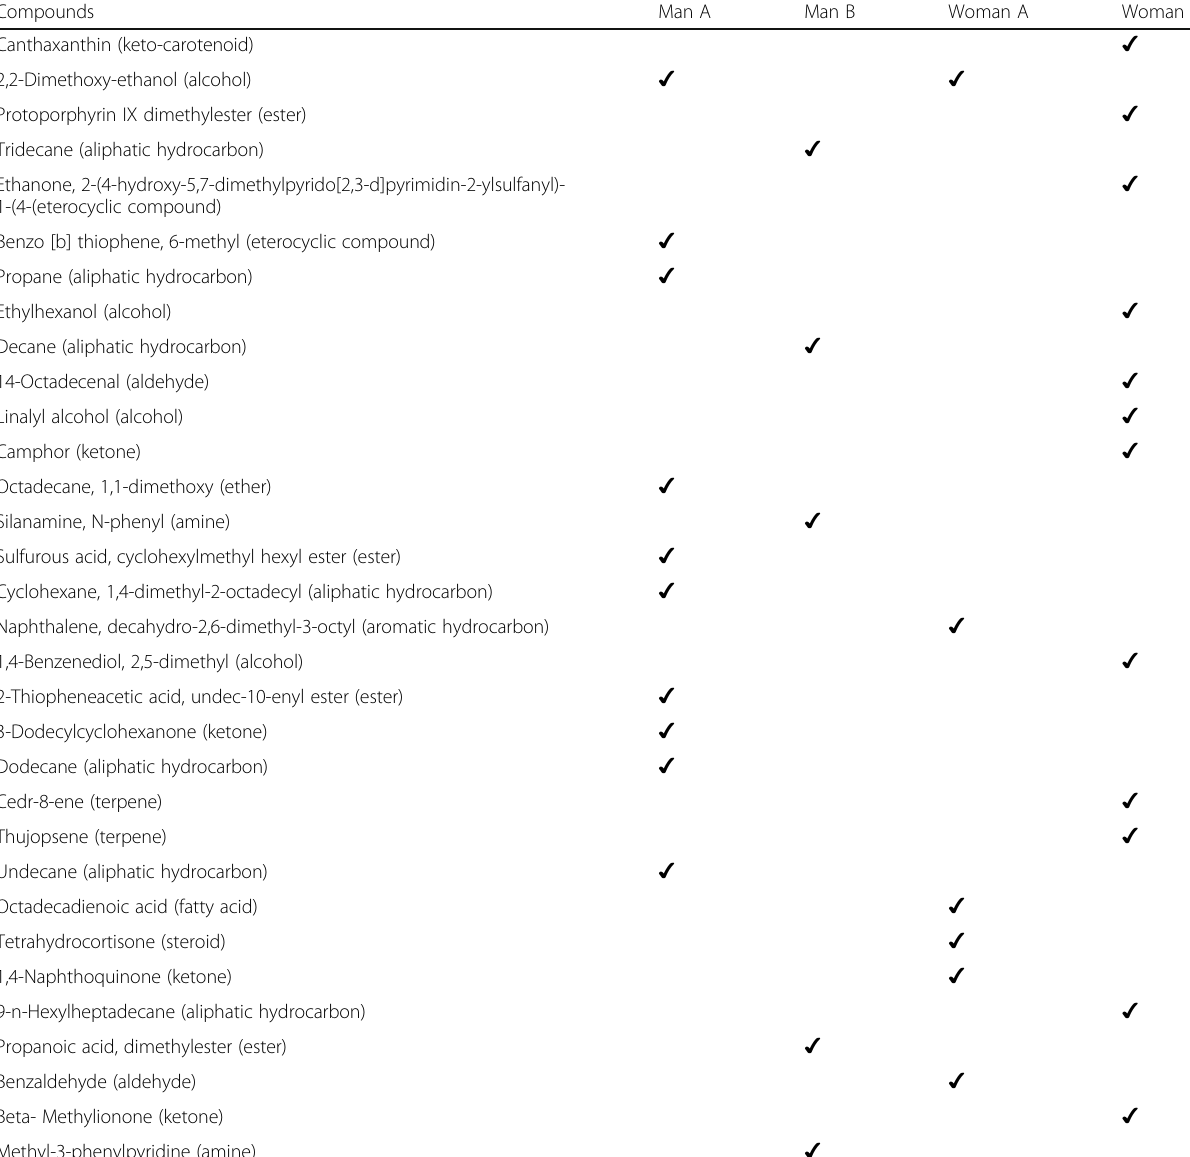
Table 2 The chemical composition of the human scent samples of the four subjects